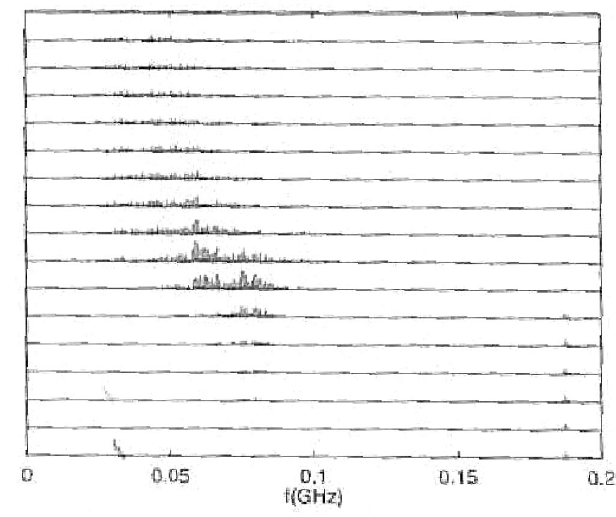
FIG. 12. Shift in AGS-booster vertical beam spectrum as the instability progressed [25]; the time advances from the bottom to the top ( 12 (cid:7) s between traces); the vertical scale extends from 0 to 0.2 GHz.